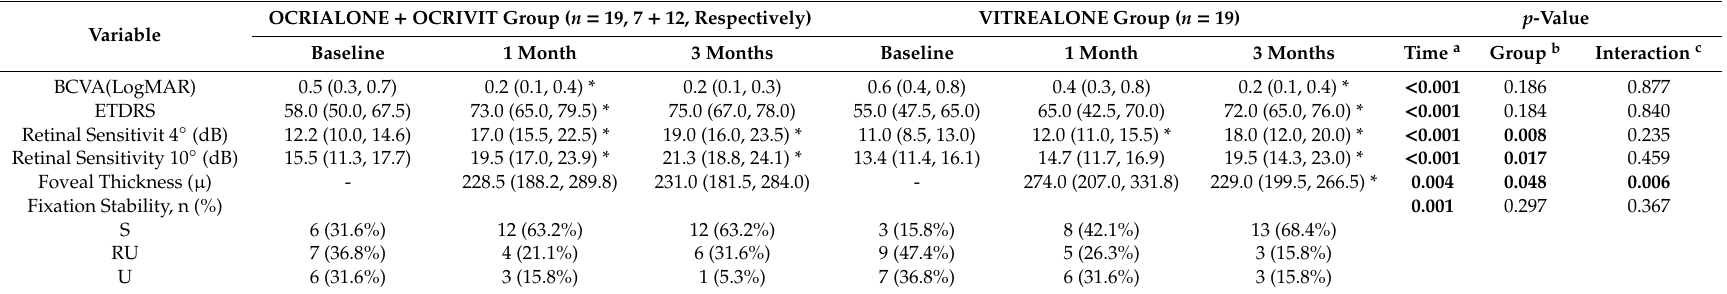
Table 2. Functional and structural findings before and after surgery in the OCRIALONE group + OCRIVIT group vs. VITREALONE.